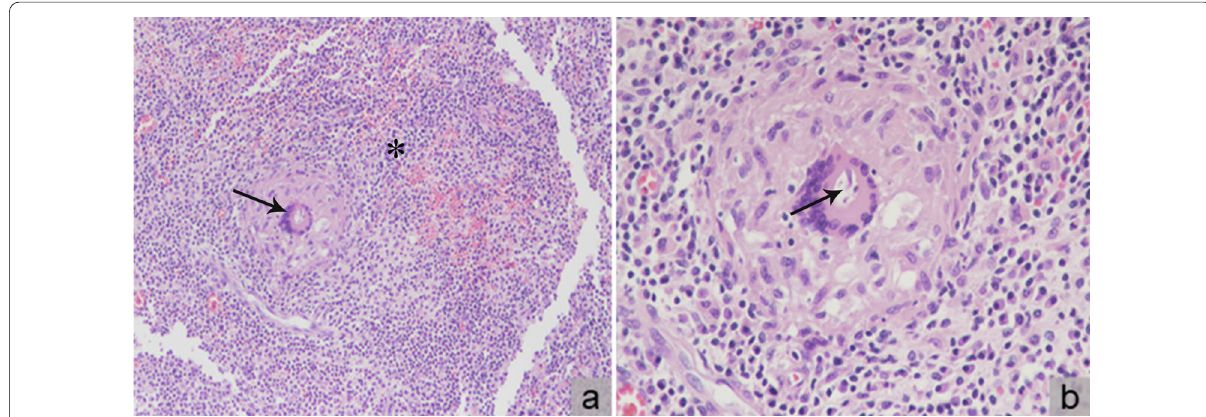
Fig. 4 Histopathological examination revealed a chronic and acute inflammatory cell infiltration, fibrosis, necrosis, degenerative leukocyte aggregation (black star), foreign body‑type giant cells, and granulomas (black arrow) under 100 magnification and b a multinucleated giant cell × engulfing the suture material (black arrow) under 400 ×